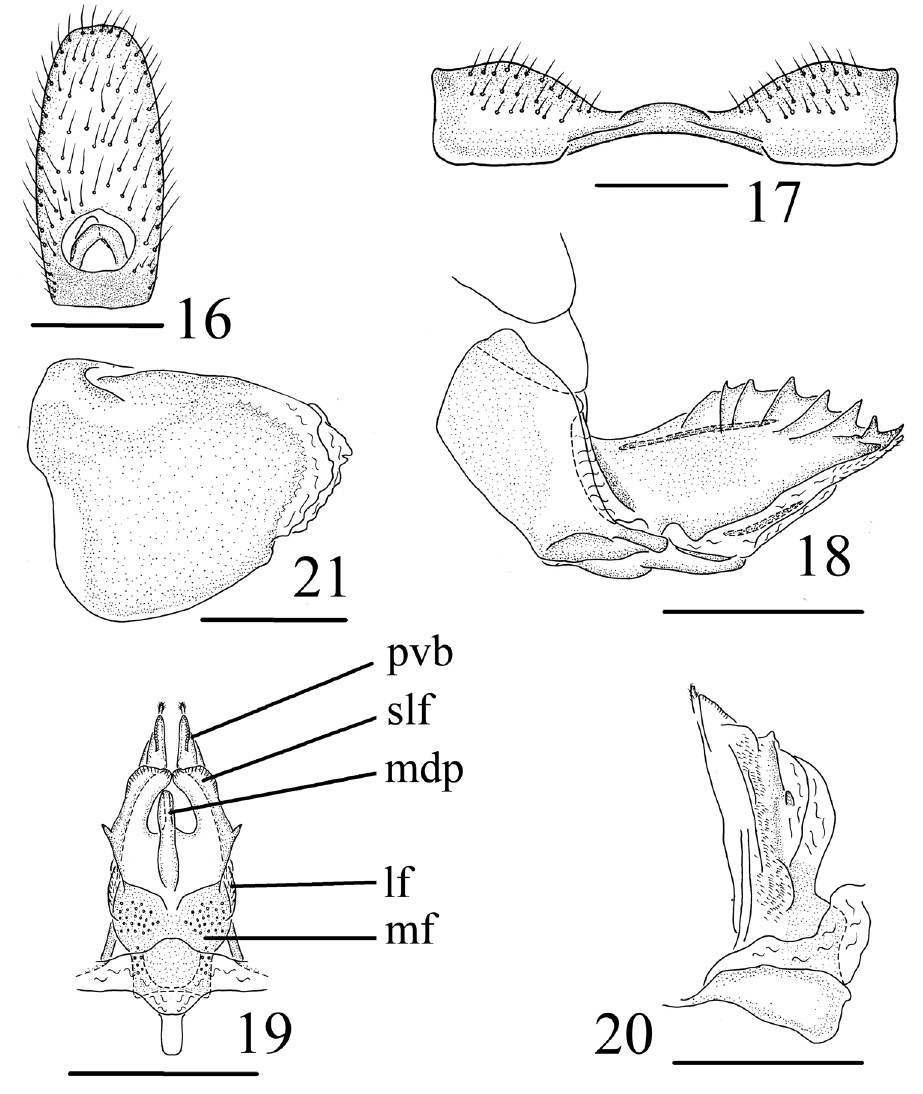
Figures 16–21. Female genitalia. Tetricodes ansatus Chang & Chen, sp. n. 16 anal segment, dorsal view 17 Sternum VII, ventral view 18 Anterior connective lamina of gonapophyses VIII, lateral view 19 Poste- rior connective lamina of gonapophyses IX, dorsal view 20 Posterior connective lamina of gonapophyses IX, lateral view 21 Gonoplacs, lateral view. Scale bars = 0.5 mm. Abbreviations. lf–lateral field of posterior connective lamina of gonapophyses IX; mdp–medial dorsal process; mf–medial field of posterior connec- tive lamina of gonapophyses IX; pvd–posterior ventral lobes; slf–sublateral field of posterior connective lamina of gonapophyses